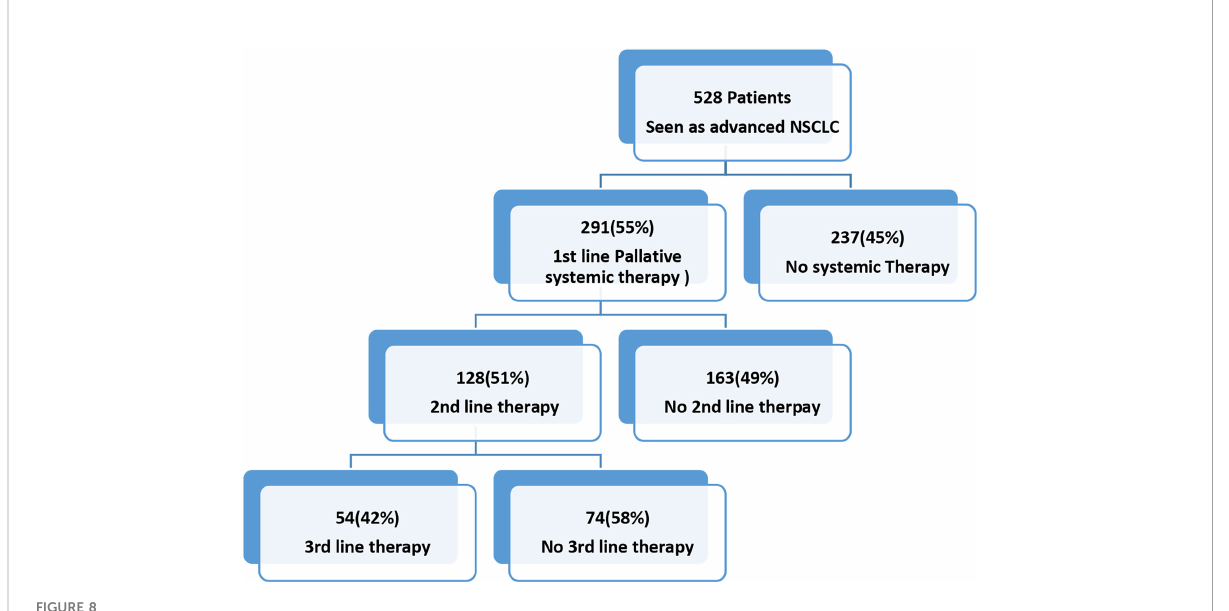
FIGURE 8 Systemic therapy uses in patients with advanced NSCLC (59,